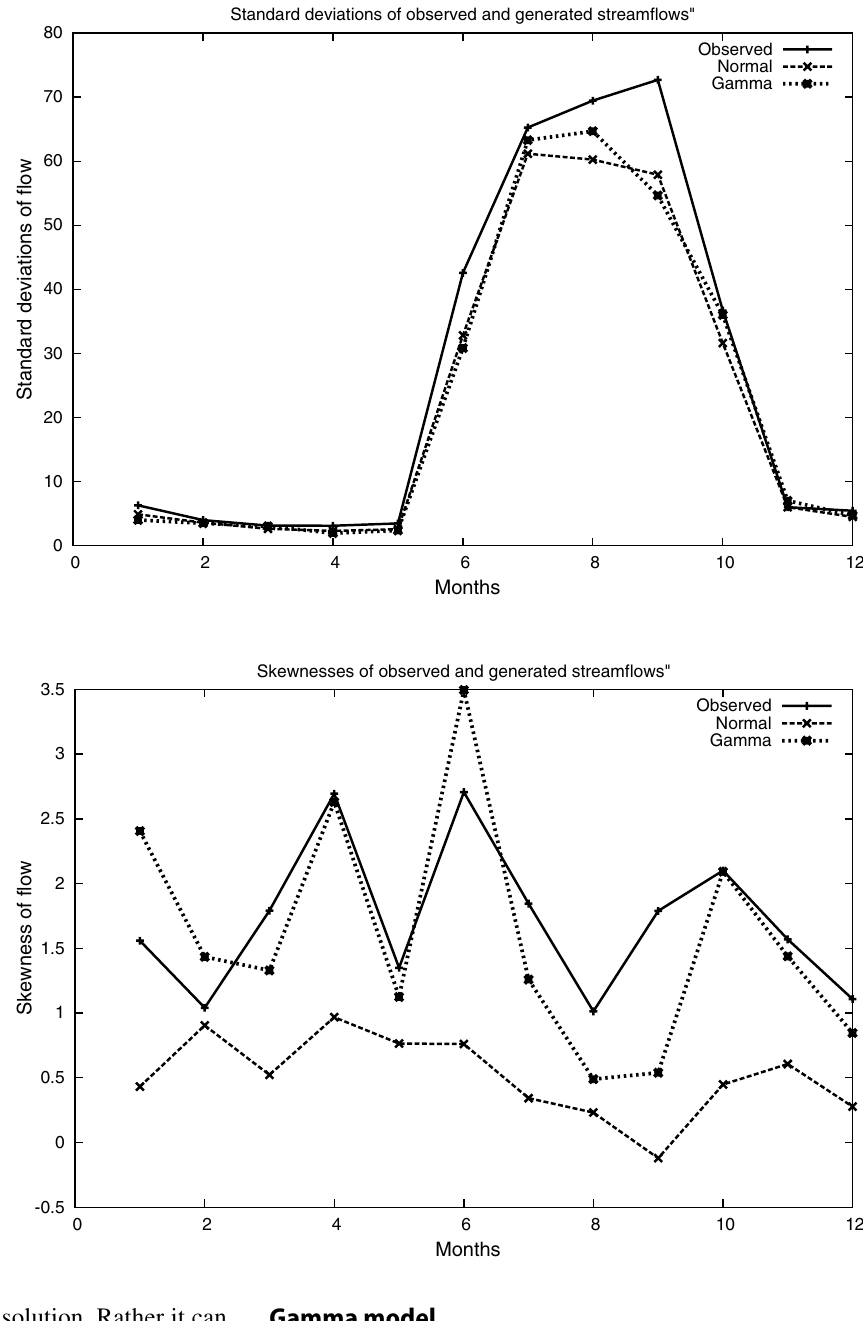
Fig. 7 Historical and generated monthly standard deviations of flows in Barakar River (single- site model)